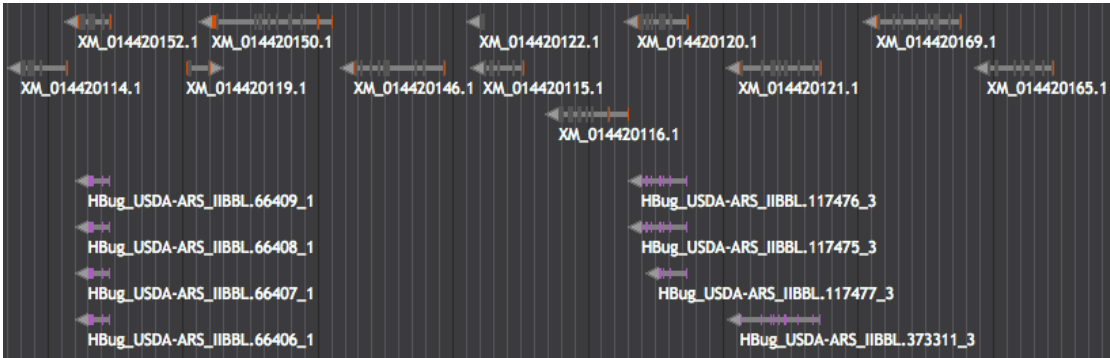
Figure 4. Segment of scaffold 261 from the Halyomorpha halys genome assembly harboring an array of eleven E4/FE4 esterase genes. The H. halys COE genes are show in the top track, in grey (note that gene model XM_014420119.1 appears to correspond to an unrelated lipase gene) a total of six unique M. histrionica proteins (bottom track, purple) could be aligned to this chromosomal region, and these associated with three distinct COE loci present in the H. halys genome sequence.